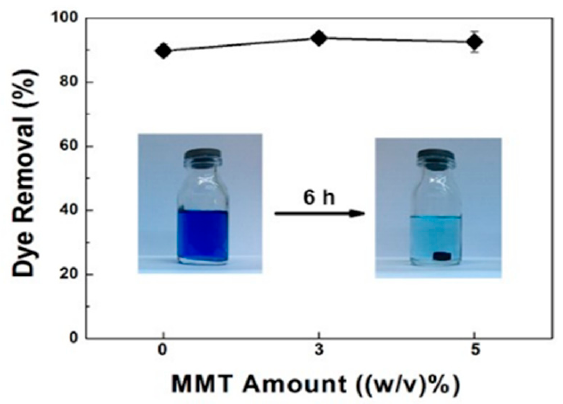
Figure 7. Dye removal (%) by composite cryogels with varying MMT content (inset: digital image of MB solution before (left) and after (right) 6 h contact with sample containing 3 ( w/v ) % of MMT) (initial dye concentration: 25 mg L − 1 , adsorbent dosage: 0.01 g, experiment duration: 6 h).